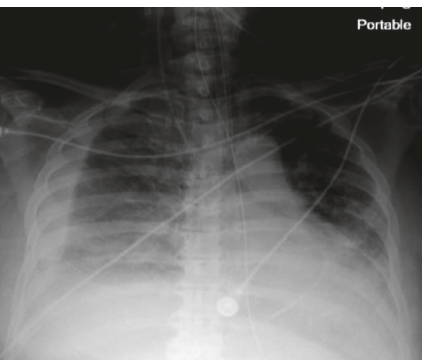
Figure 2: Post-op X-ray showing a foreign catheter tip in the